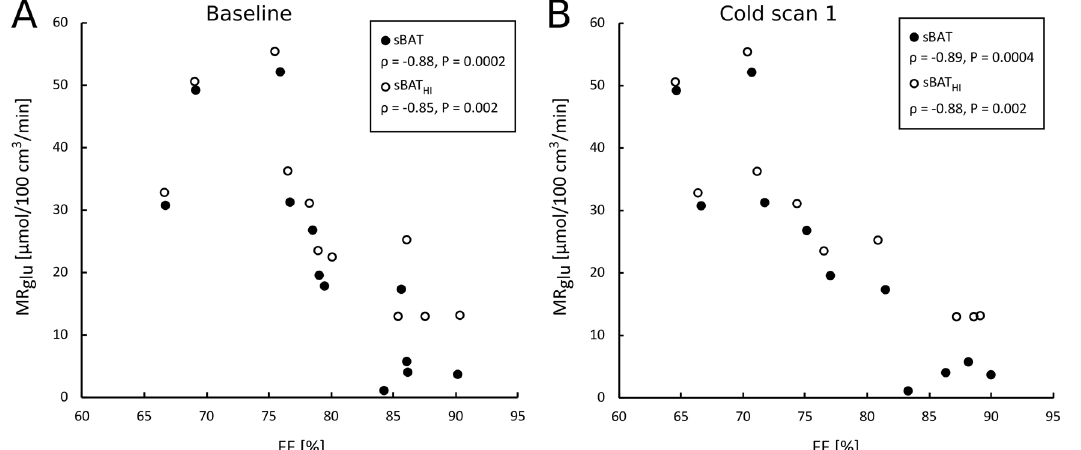
Figure 3. Correlation between MR glu and FF in sBAT and sBAT HI at (A) baseline and (B) the end of ~ 3 h of cold exposure (cold scan 1). ρ, Spearman rank-order correlation